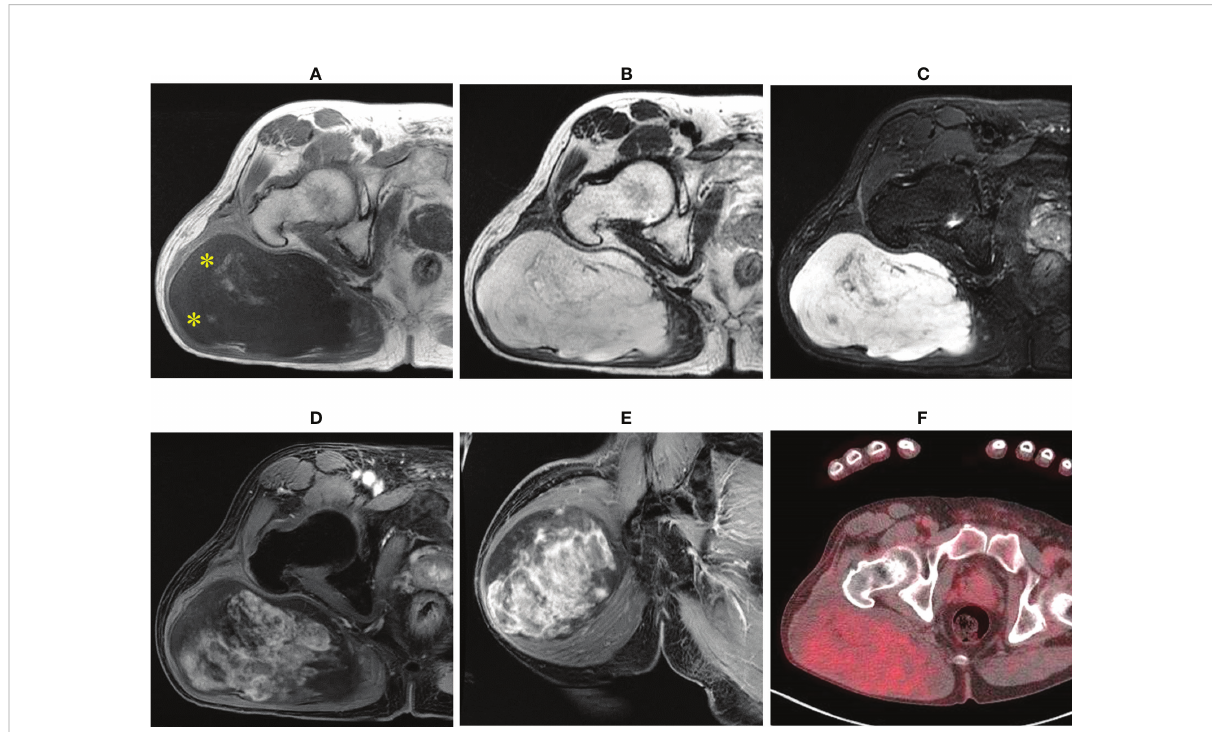
FIGURE 1 Imaging fi ndings. T1-weighted axial images showing low and slightly high signals (yellow asterisk) (A) ; almost homogeneous high signal on T2- weighted images (B) and short tau inversion recovery images (C) ; and axial and central enhancement on a gadolinium-enhanced T1-weighted axial image (D, E) . Axial fl uorodeoxyglucose (FDG) positron emission tomography-computed tomography (PET-CT) showing a hypometabolic tumor (F)